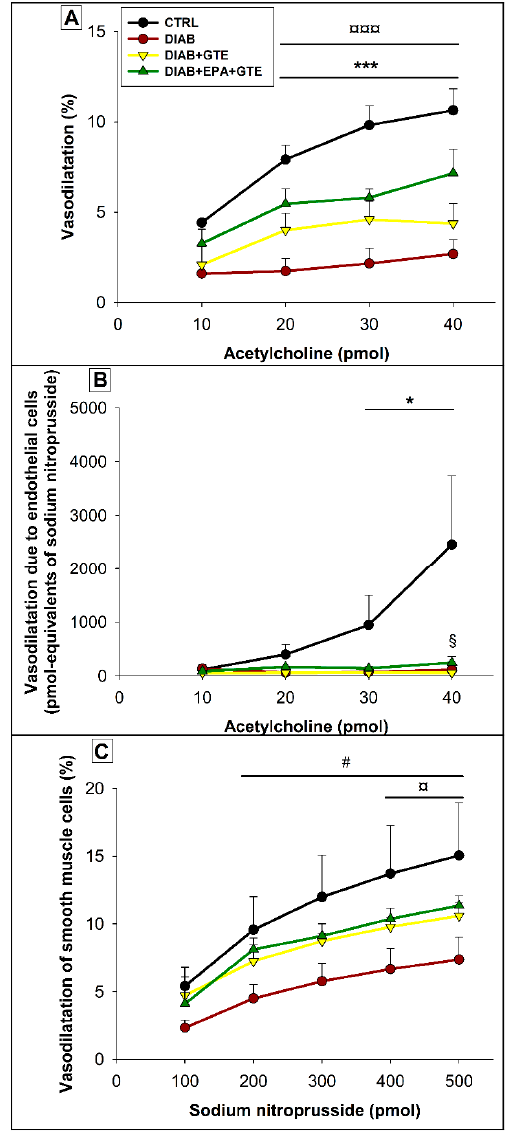
Figure 5. Coronary reactivity. ( A ) Endothelial-dependent vasodilatation due to the combined activities of endothelial and smooth muscle; ( B ) Endothelial cell vasodilation capacities; and ( C ) Endothelial-independent vasodilatation due the smooth muscle cells. CTRL: Control group; DIAB: Diabetic rats; GTE: Green tea extract enrichment; and EPA: Eicosapentaenoic acid enrichment. * CTRL group di ff erent to the others groups; #: CTRL group di ff erent to the DIAB group; ¤: DIAB group di ff erent to the DIAB + EPA + GTE group; and §: DIAB + GTE group di ff erent to the DIAB + EPA + GTE group. One symbol: p < 0.05; two symbols : p < 0.01; and three symbols : p < 0.001.